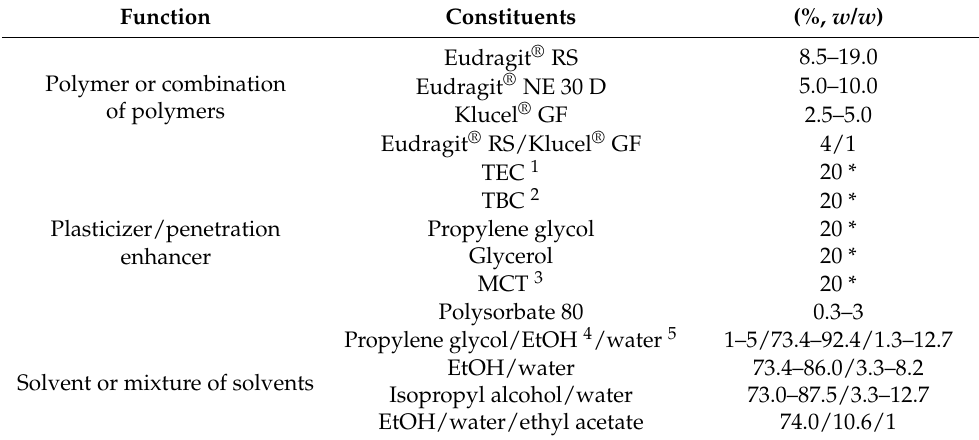
Solvent or mixture of solvents